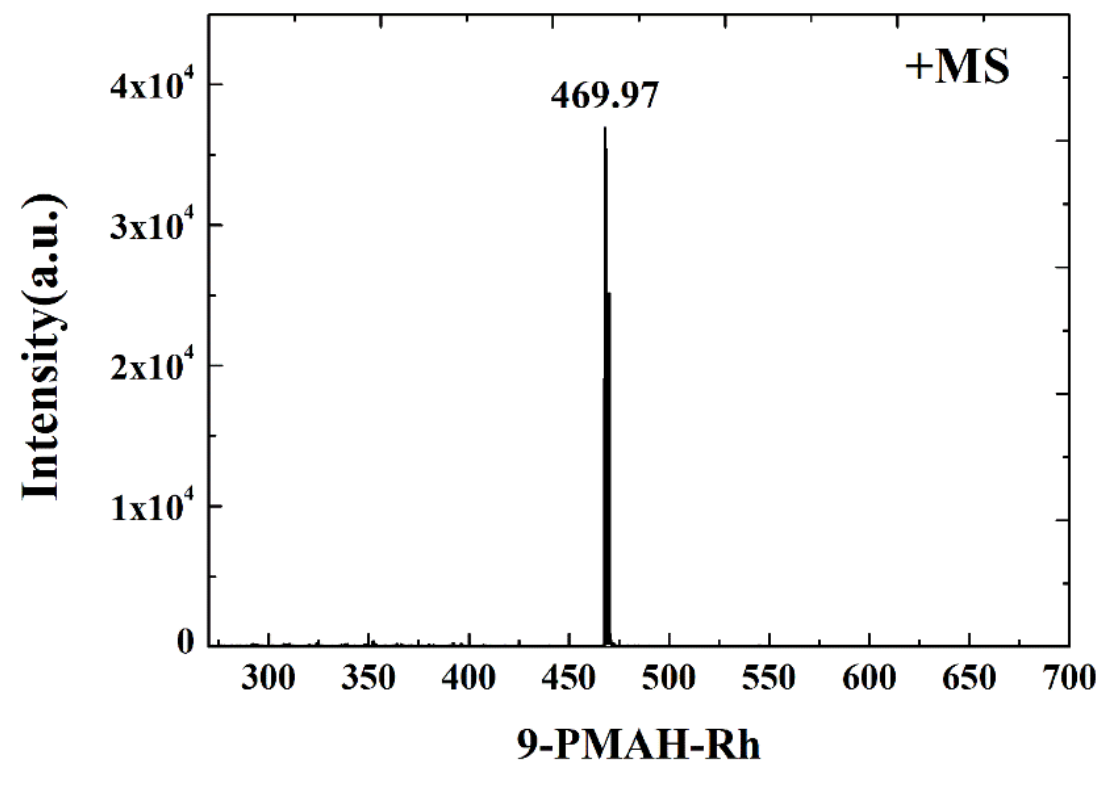
Figure 4. The ESI-MS analysis of 9-PMAH-Rh in methanol solution.